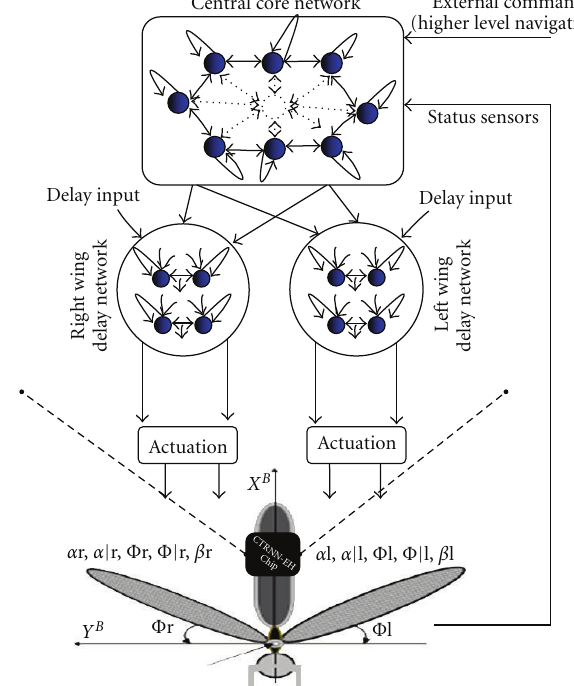
Figure 4: Interfacing CTRNN Architecture to MFWR Model to evolve and analyze flight controllers. In the figure, α (with range − 90 to 90) indicates the instantaneous rotational angle of the wing, Φ (with range − 60 to 60) indicates the instantaneous stroke angle of the wing, and β (with range − 45 to 45) indicates the instantaneous stroke plane angle of the wing. The parameters with “ | ” indicate the rate of change for the parameter it is referring to and these parameters with “r” and “l” indicate the right (r) and left (l) wing parameters, respectively.